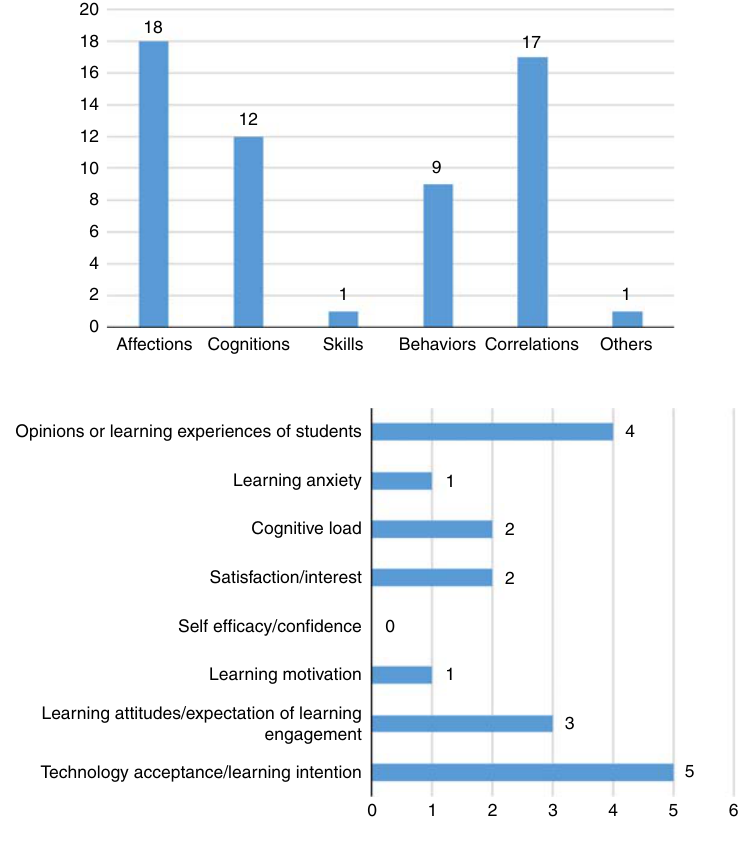
Figure 12. The distribution of the eight subcategories of